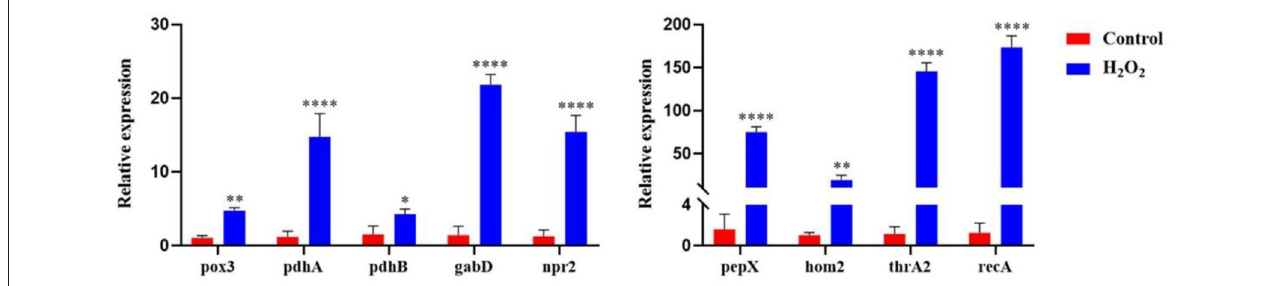
FIGURE 7 | The relative expression of genes encoding DEPs in L. plantarum KM1 under H 2 O 2 stress Red: control group; blue: H 2 O 2 group. * p < 0.05; ** p < 0.01; and **** p < 0.0001.